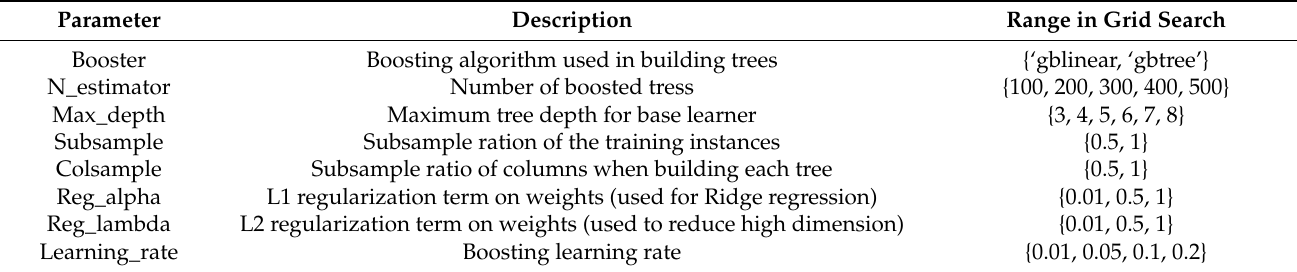
Table 3. Details for XGBoost (extreme gradient boosting) structure by grid